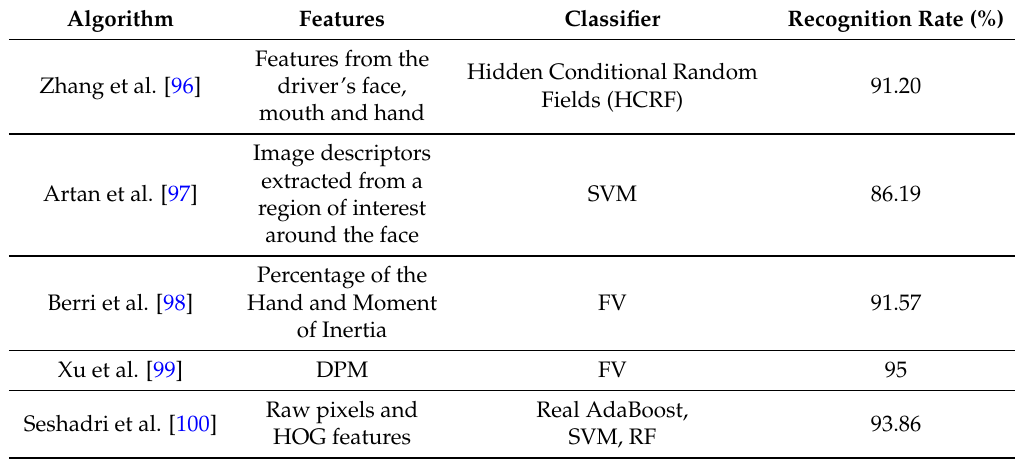
Table 3. Computer vision algorithms to detect cell phone usage. High recognition rates are usually obtained using very different